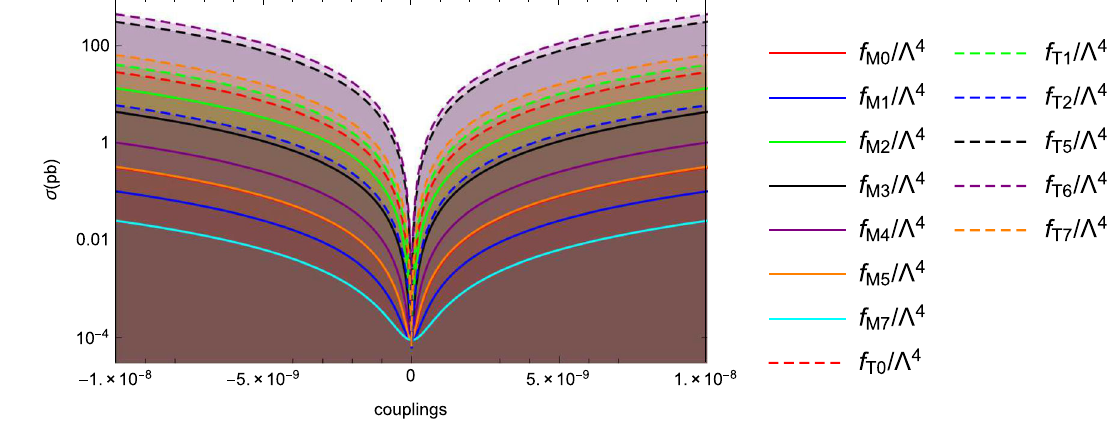
Fig. 6 Same as in Fig. 4, but for hadronic decay